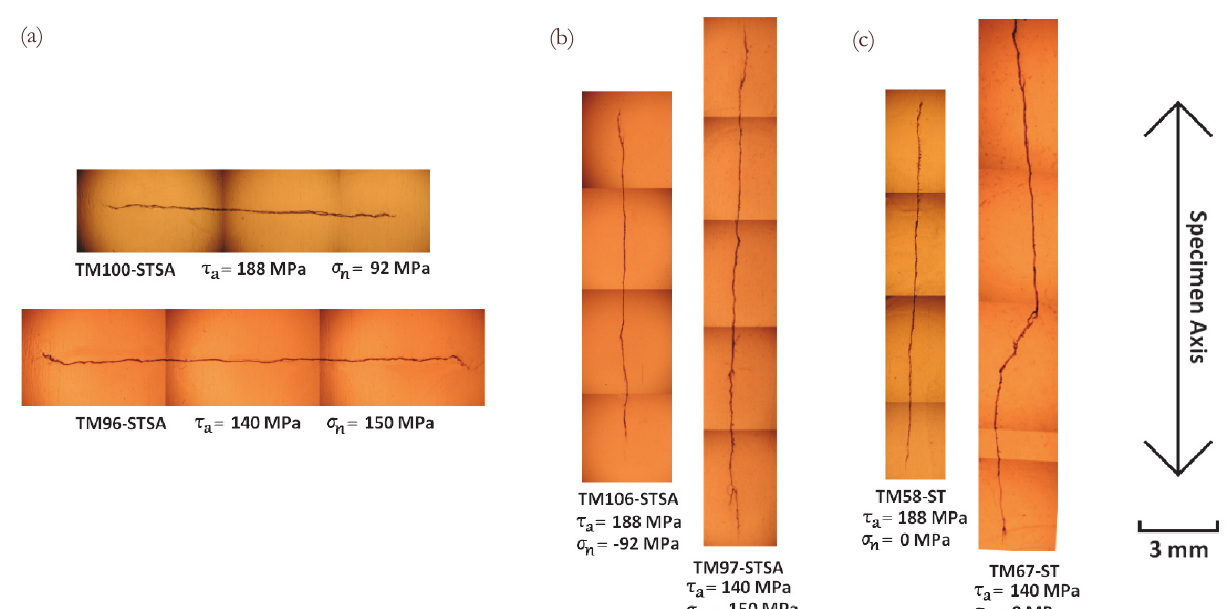
Figure 5: Final crack paths for selected smooth specimen tests under (a) torsion with static tensile stress, (b) torsion with static compressive stress, and (c) pure torsion